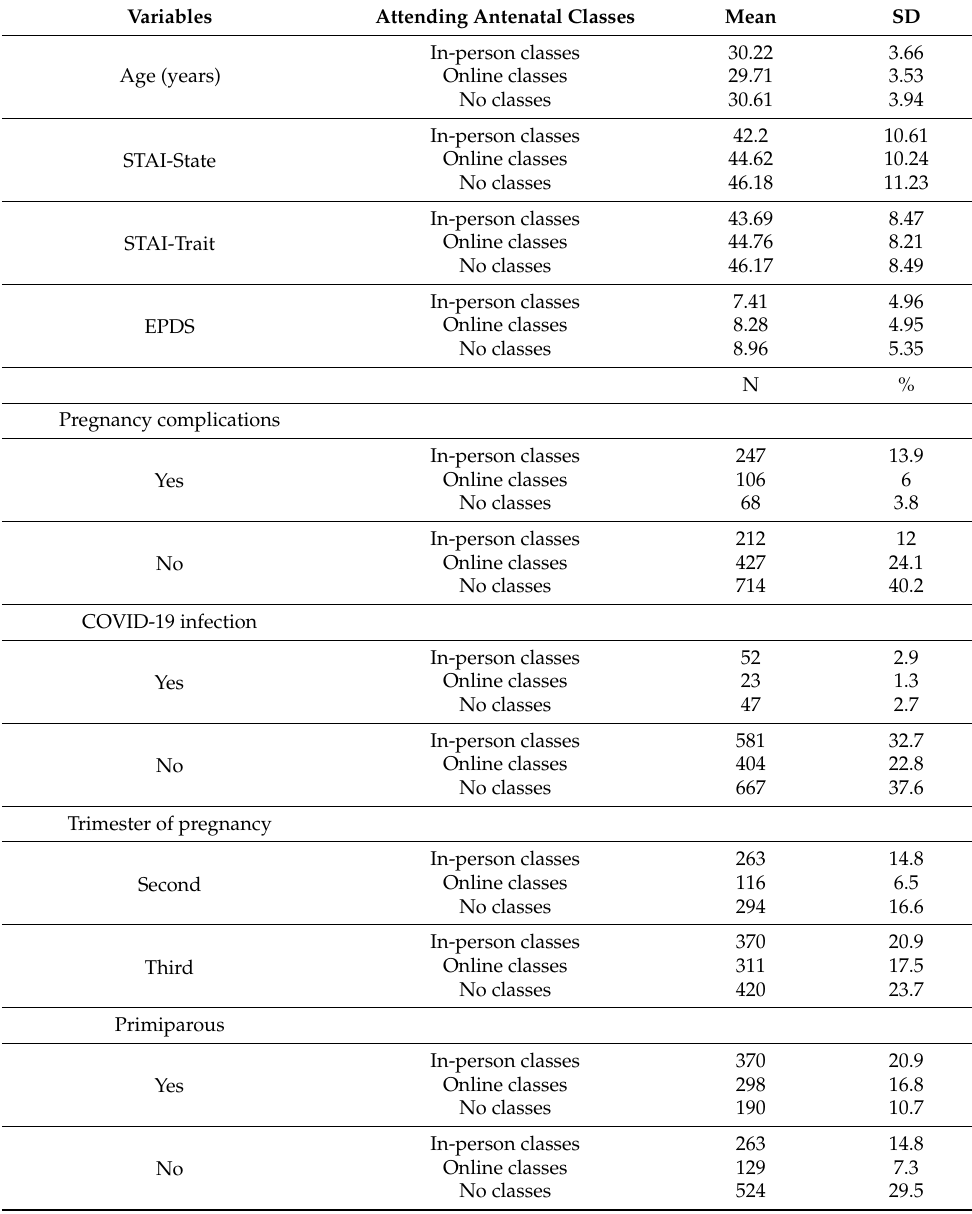
Table 1. Descriptive statistics of the variables in the study